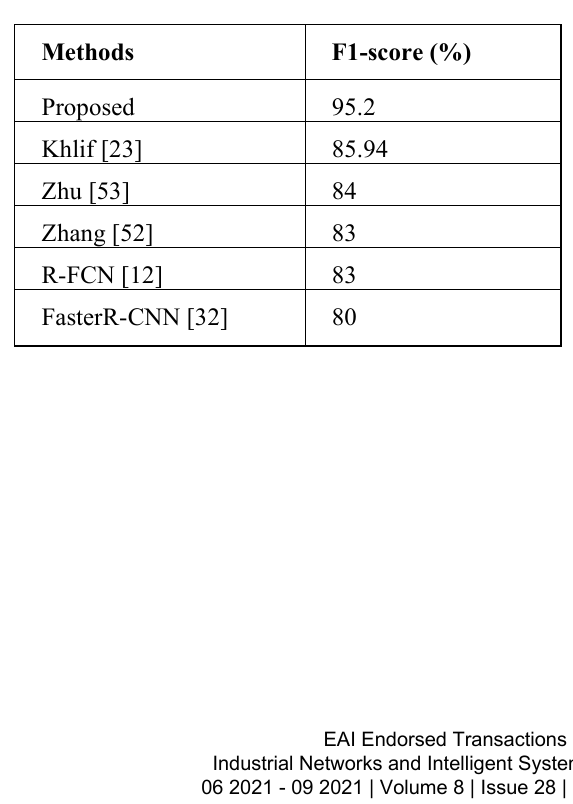
Table 5. F1-score for suggested and